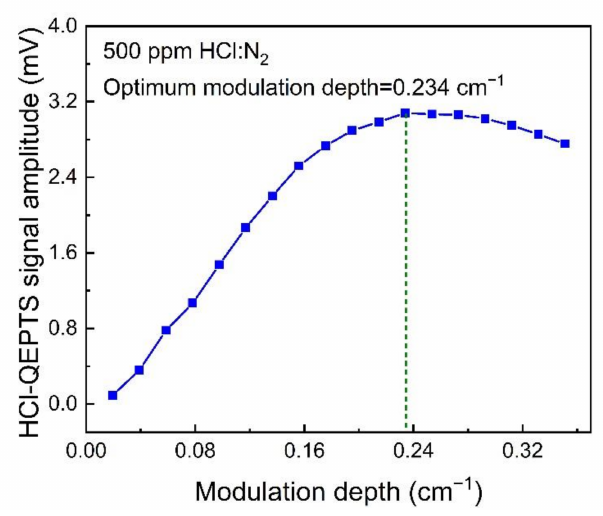
Figure 3. HCl-QEPTS 2 f signal amplitude as a function of the modulation depth. The blue solid line is a guide for visually connecting the experimental data points. The green dotted line is used to mark the optimum modulation depth.